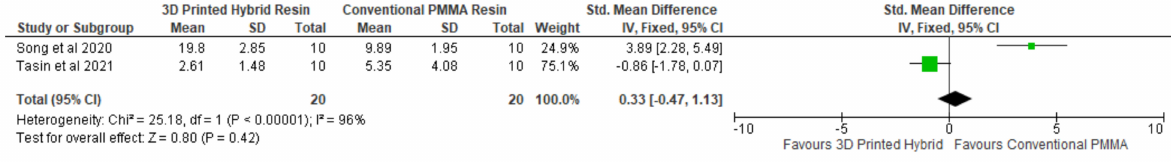
Figure 3. Forest plot comparing color change between 3D-printed hybrid resin and conventional PMMA resin.